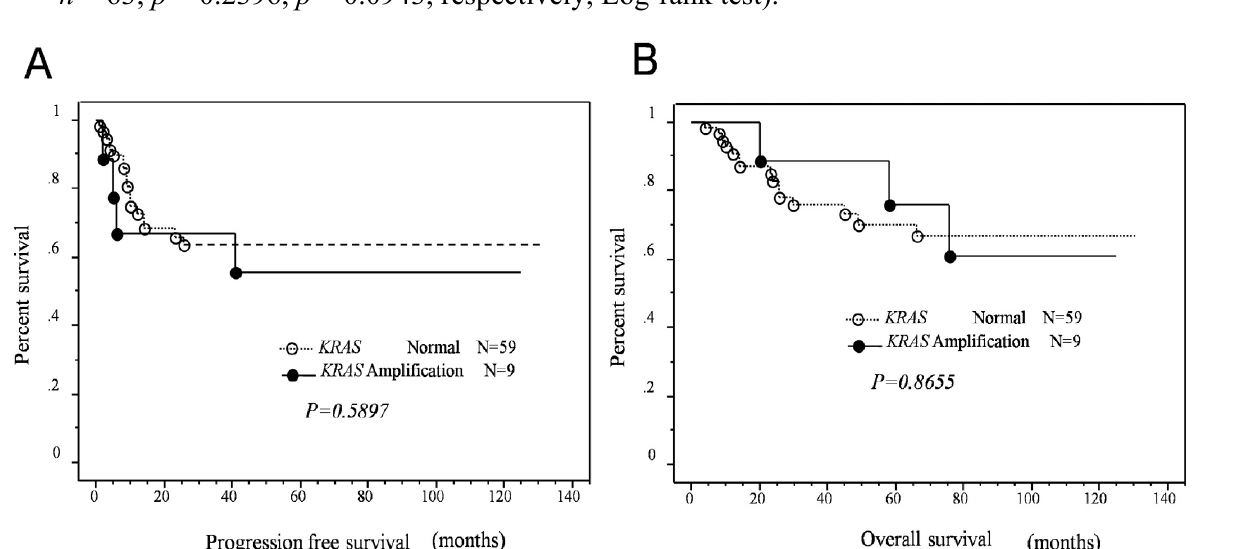
Figure 2. Relationship between KRAS / MAPK1 amplification or p-ERK expression status and progression-free/overall survival in patients who received primary cytoreductive surgery followed by standard platinum/taxane chemotherapy. ( A , B ) Kaplan-Meier survival analysis showed that KRAS amplification (solid line, n = 9) was not associated with a shorter progression-free/overall survival than absence of KRAS amplification (dashed line, n = 59; p = 0.5897 , p = 0.8655 , respectively, Log-rank test); ( C ) Kaplan-Meier survival analysis showed that MAPK1 amplification (solid line, n = 5) was associated with a shorter progression-free survival than absence of MAPK1 amplification (dashed line, n = 63; p = 0.0098, Log-rank test); ( D ) MAPK1 amplification (solid line, n = 5) tended to be correlated with a shorter overall survival than absence of MAPK1 amplification, but was not statistically significant (dashed line, n = 63; p = 0.1658, Log-rank test); ( E , F ) Positive p-ERK expression tended to be correlated with a shorter progression-free/overall survival than absence of MAPK1 amplification, but was not statistically significant (dashed line, n = 63; p = 0.2396, p = 0.0943, respectively, Log-rank